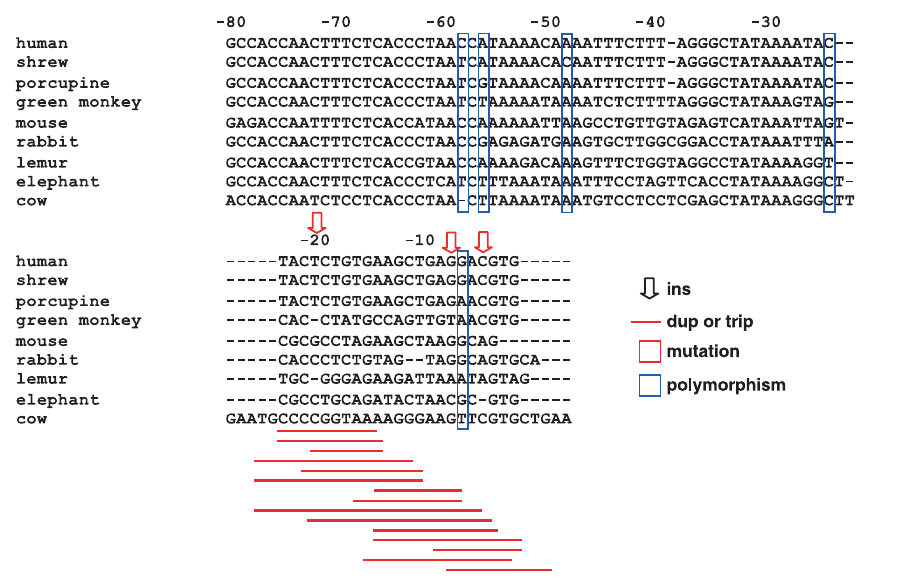
Figure S1. Microsatellite Marker Analysis of the Region around RMRP in Family 27